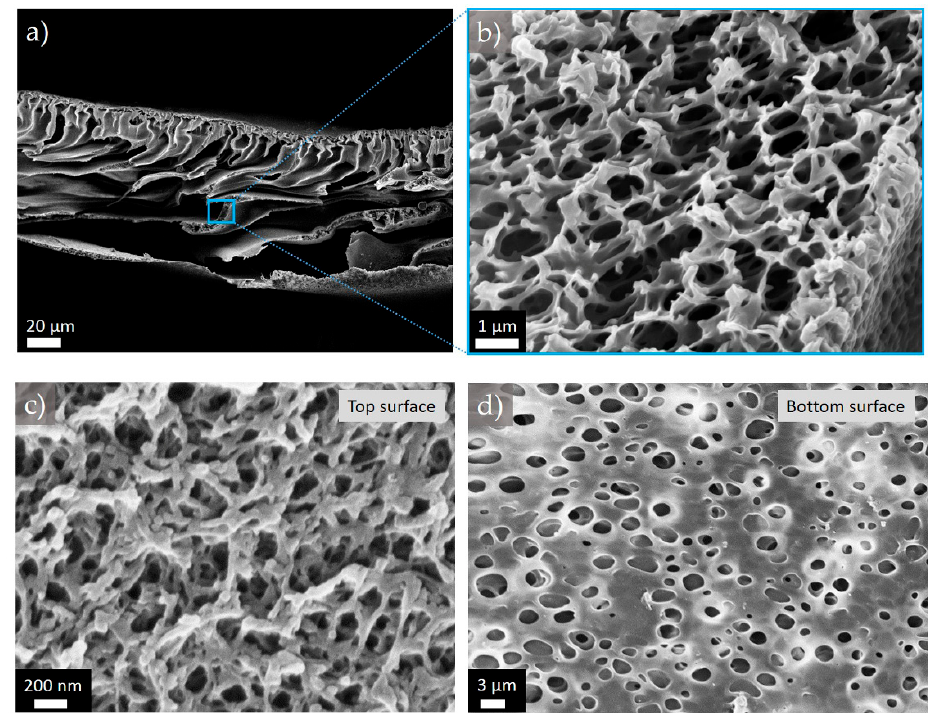
Figure 4. Representative SEM images obtained for the membrane M1-6: ( a ) and ( b ) cross-section at two different magnifications; ( c ) top and ( d ) bottom surface structures. Polymers 2018 , 10 , 59